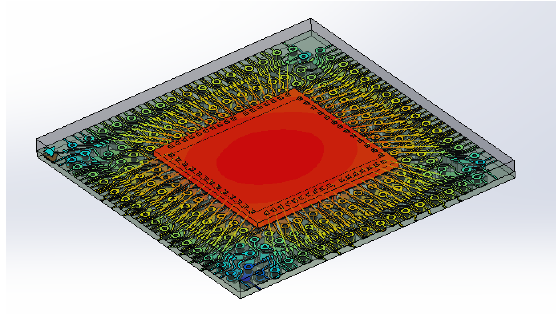
Figure 6. BGA208’s numerical model. Figure 6. BGA208‘s numerical model.